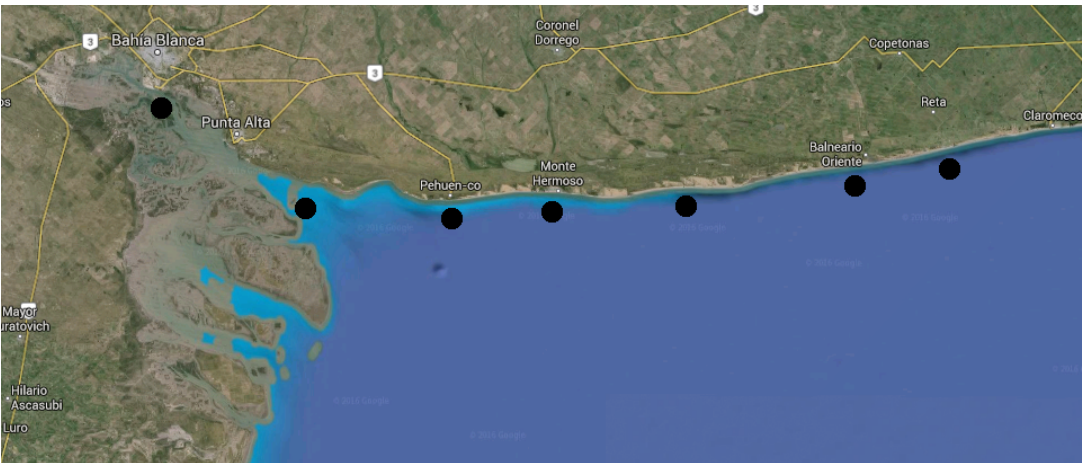
Figure 14. Satellite picture of the Bahia Blanca